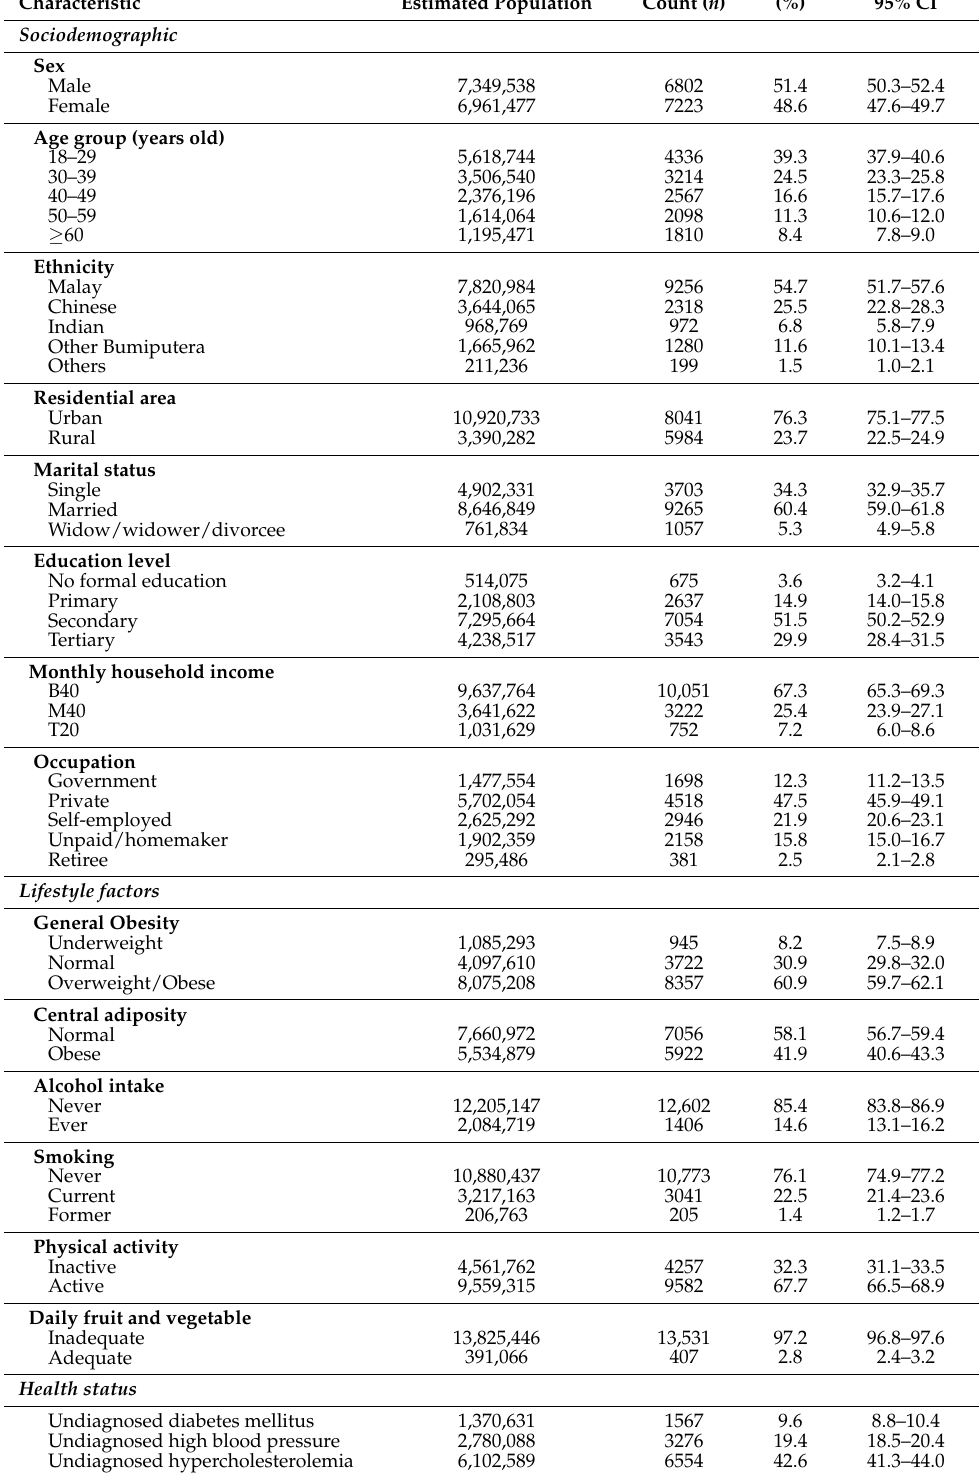
Table 1. Characteristics of the Malaysian adult respondents aged 18 years and above ( n = 14,025).